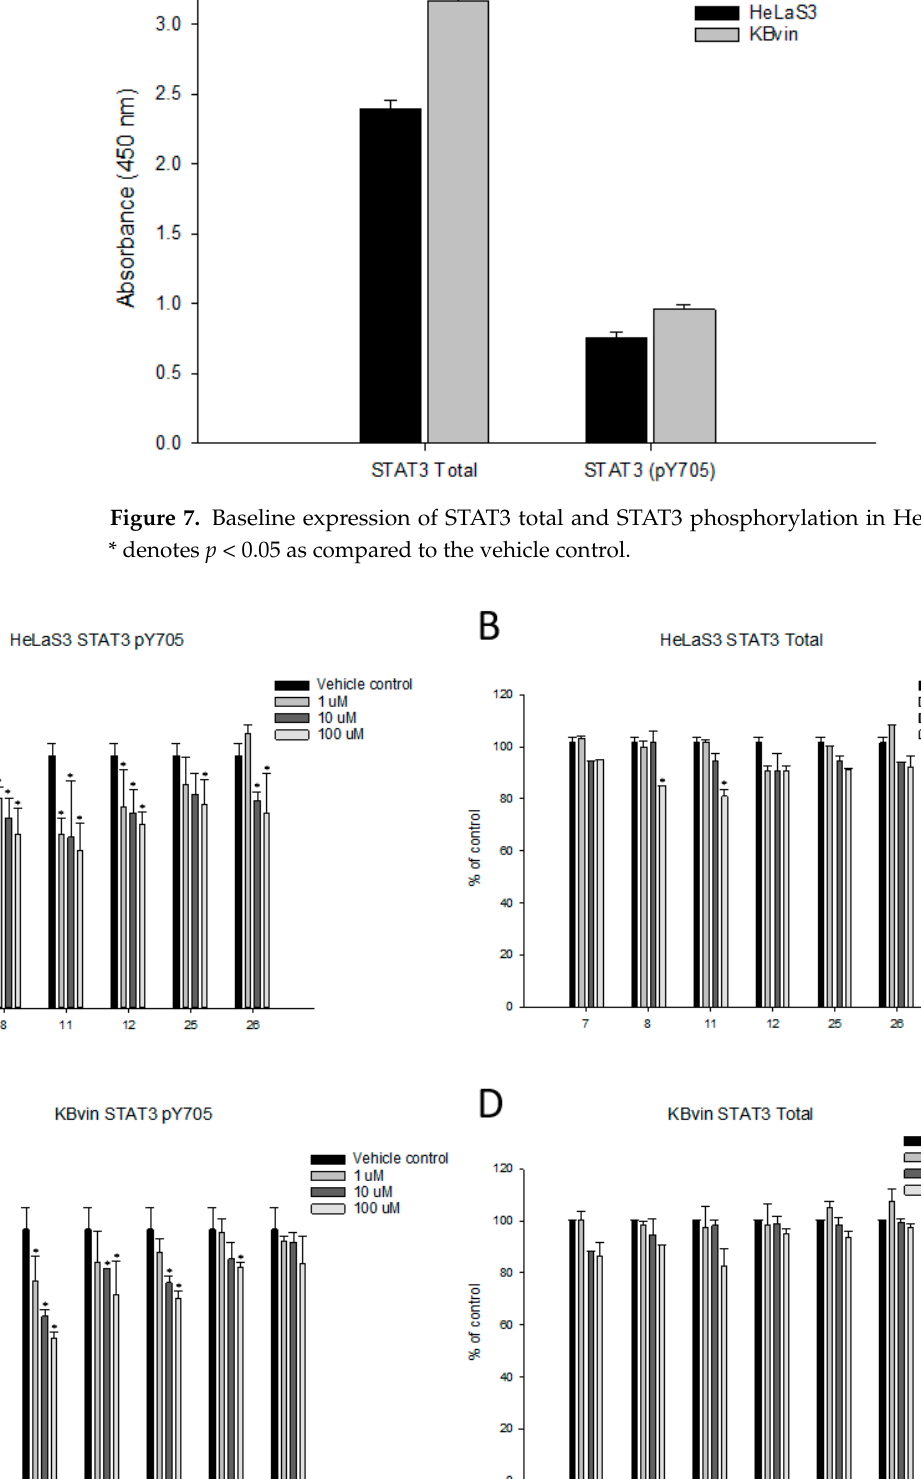
Figure 8. Effects of the testing compounds on the expression of STAT3 phosphorylated at Tyr705 and total STAT3 proteins in the HeLaS3 cells ( A , B ) and KBvin cells ( C , D ). * denotes p < 0.05 as compared to the vehicle control.